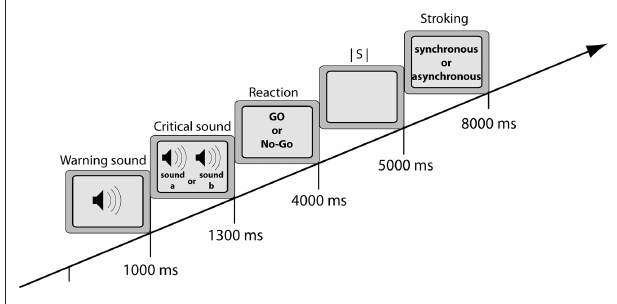
Figure 2 | Stimulus sequence in each trial. Trials started with the presentation of the warning sound. After 1000 ms, the critical sound (either A or B) appeared on the left or right of both participants. Participants had to respond within 3000 ms. The reaction was followed by an inter-stimulus- interval (ISI) of 1000 ms and 3000